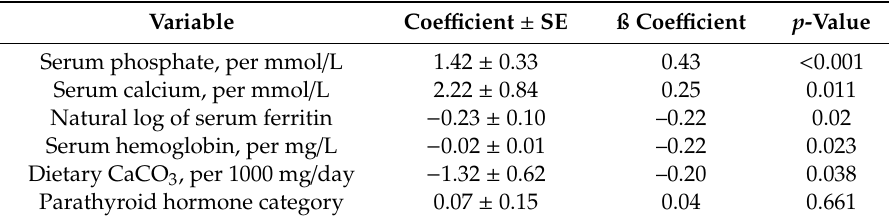
Table 5. Simple multivariable model to predict natural log of FGF23 (adjusted r 2 =